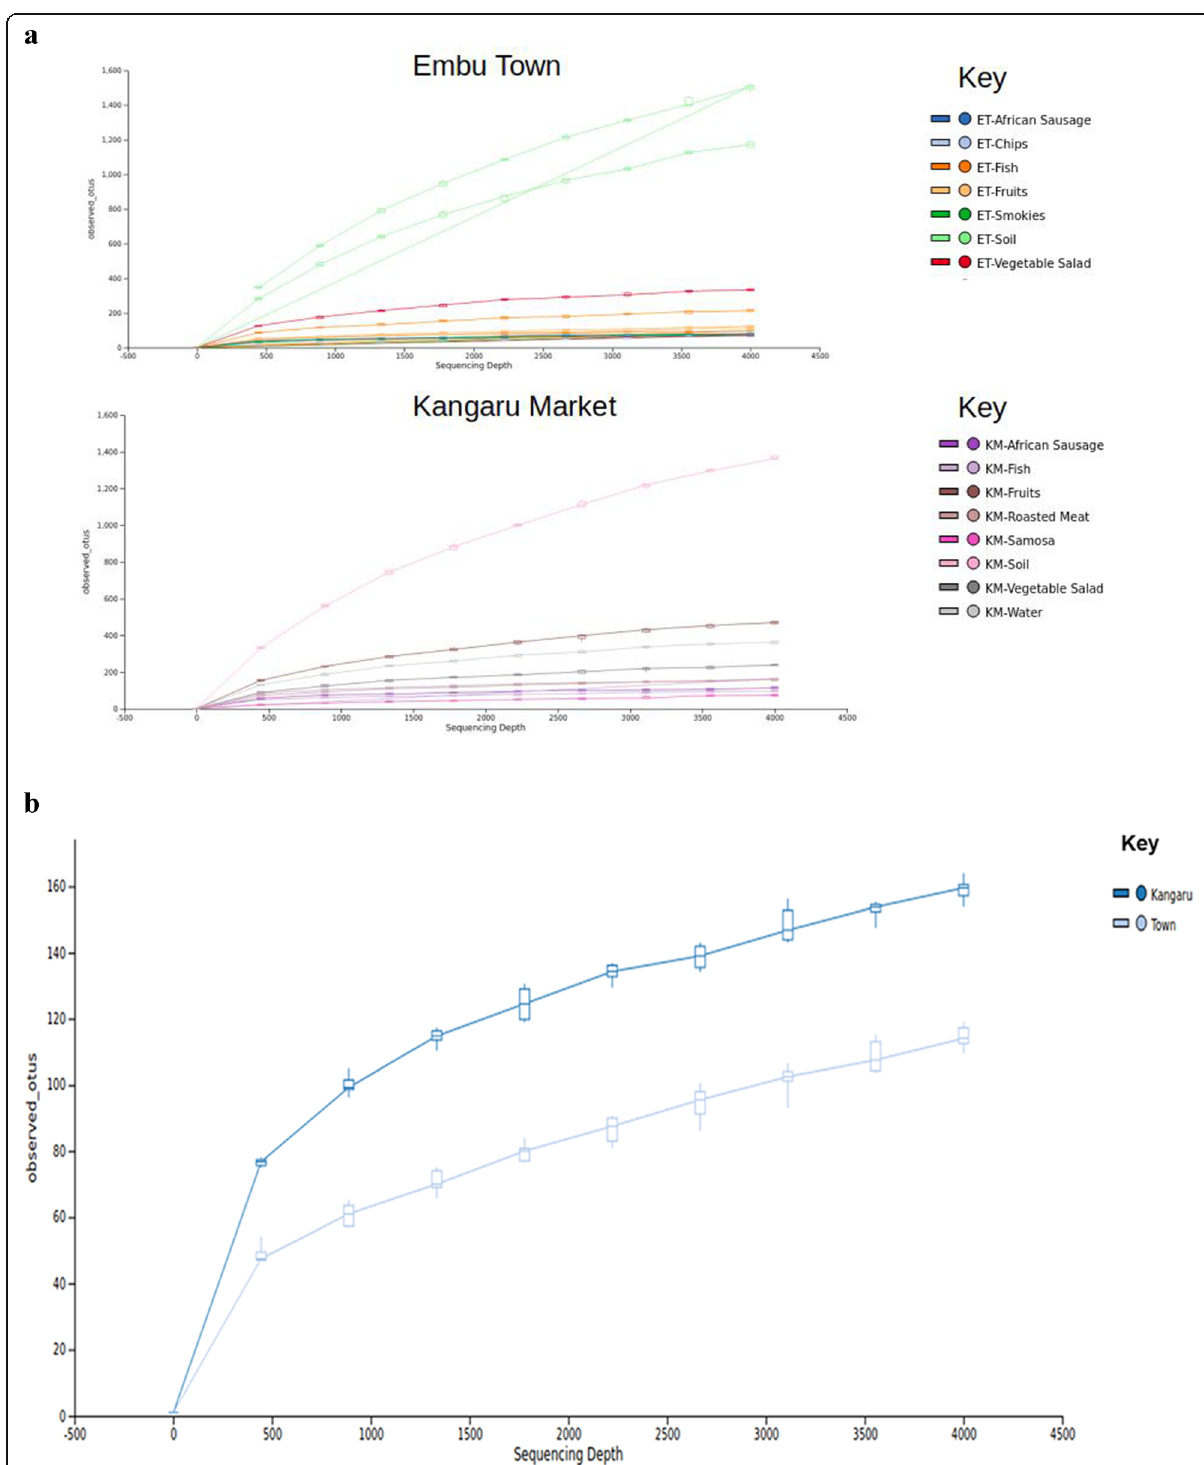
Fig. 1 a The number of operational taxonomic units (OTUs) as a function of sequence reads from the analyses of vended foods, soil, and water samples from Embu Town and Kangaru Market in Embu County. b Operational taxonomic units (OTUs) at different sequencing depths in vended food and environmental samples from Embu Town and Kangaru Market in Embu County,